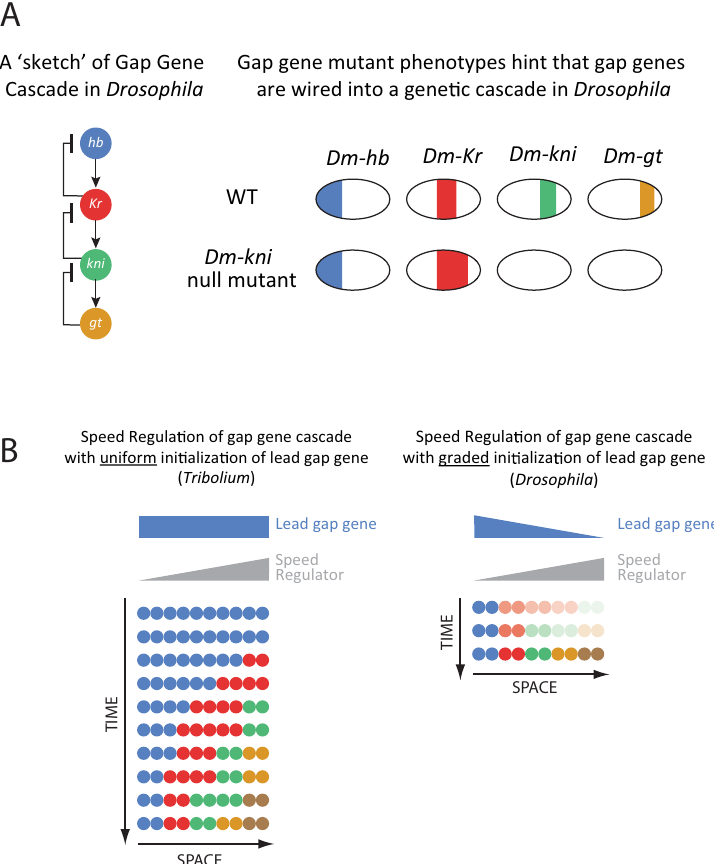
Fig 8. A model toward reconciliation of simultaneous and sequential modes of AP patterning in insects. (A) Right: In a loss of function mutant of a Drosophila gap gene (here shown only Dm-kni mutant), gap gene expression anterior to it is extended (here Dm-Kr ), and gap gene expression posterior to it is missing (here shown for Dm-gt ). This is reminiscent of the gap gene phenotypes in Tribolium (compare with Fig 4E and 4F) and suggests that gap genes in Drosophila are wired into a genetic cascade as well (see the sketch of a gene network to the left; note that this is a parsimonious wiring explaining observed gene expression dynamics in WT and mutant phenotypes, where wiring might differ from the one shown, especially that most gap genes are known to act as repressors rather than activators). (B) A model for the evolution of gap gene regulation in insects from a sequential mode of patterning (like in Tribolium ) to a simultaneous mode (like in Drosophila ). Left: Typical speed regulation model for producing nonperiodic patterns (Box 3), in which the leading gene in the gene sequence (blue) is initially uniformly expressed. Right: Expressing the leading gene in the gene sequence (blue) in a graded fashion result in speedy and seemingly simultaneous patterning [9]. AP, anterior–posterior. periodic expression of pair-rule genes is not generated by a dedicated clock at all, but by instructive cues from gap gene expressions. However, the complete breakdown of the periodic pair-rule expression upon knocking down any of the primary pair-rule genes in Tribolium [60], and the limited effect that gap gene knockdowns have on pair-rule expressions disfavors this model. A combination of a clock-based model and a model based on an instructive role by gap genes is still a possibility. In yet another model, ancestral insects like Tribolium might lack a full set of stripe-specific enhancers (although one study reports the existence of such ele- ments for the pair-rule gene hairy in Tribolium [256]), and in the path to the evolution to a Drosophila -like mode of segmentation, stripe-specific enhancers regulated by gap genes might have then been added one by one, initially to ensure the robustness of segmentation, but later